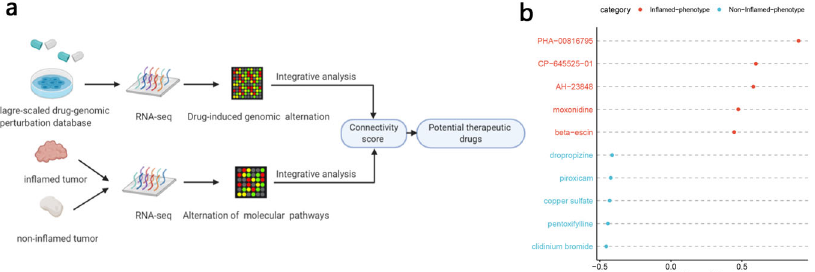
Fig. 6 Analysis combining pharmacogenomic perturbation database screens of multiple drugs that have the potential to promote in fl amed or nonin fl amed immunophenotypic switching. a The schematic plot shows the work fl ow for identifying potential drugs that can shape the tumor microenvironment. b The dot plots show potential adjuvant drugs that may contribute to favorable immunophenotype transformation. Red: drugs that may induce systematic transcriptomic alternation from a nonin fl amed TME to an in fl amed TME. Blue: opposite drugs. Connectivity is a score calculated by the PharmacoGx package based on the CMAP algorithm, and it represents the drug ’ s potential to convert the transcriptomic characteristics of “ cold ” tumors into “ hot ”